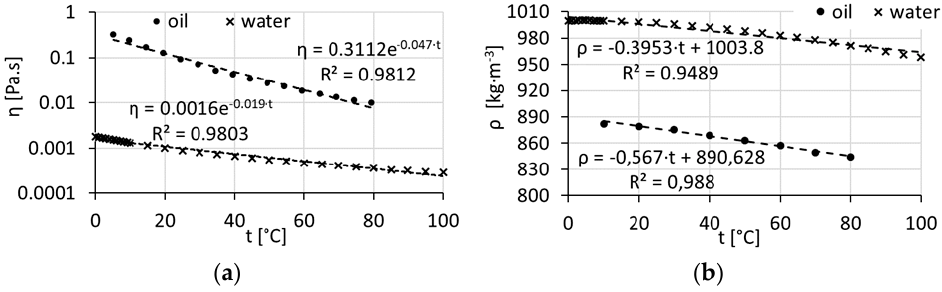
Figure 1. Physical properties of fluids. ( a ) Dependence of dynamic viscosity 𝜂 vs. temperature 𝑡 ; ( b ) Dependence of density 𝜚 vs. temperature 𝑡 .